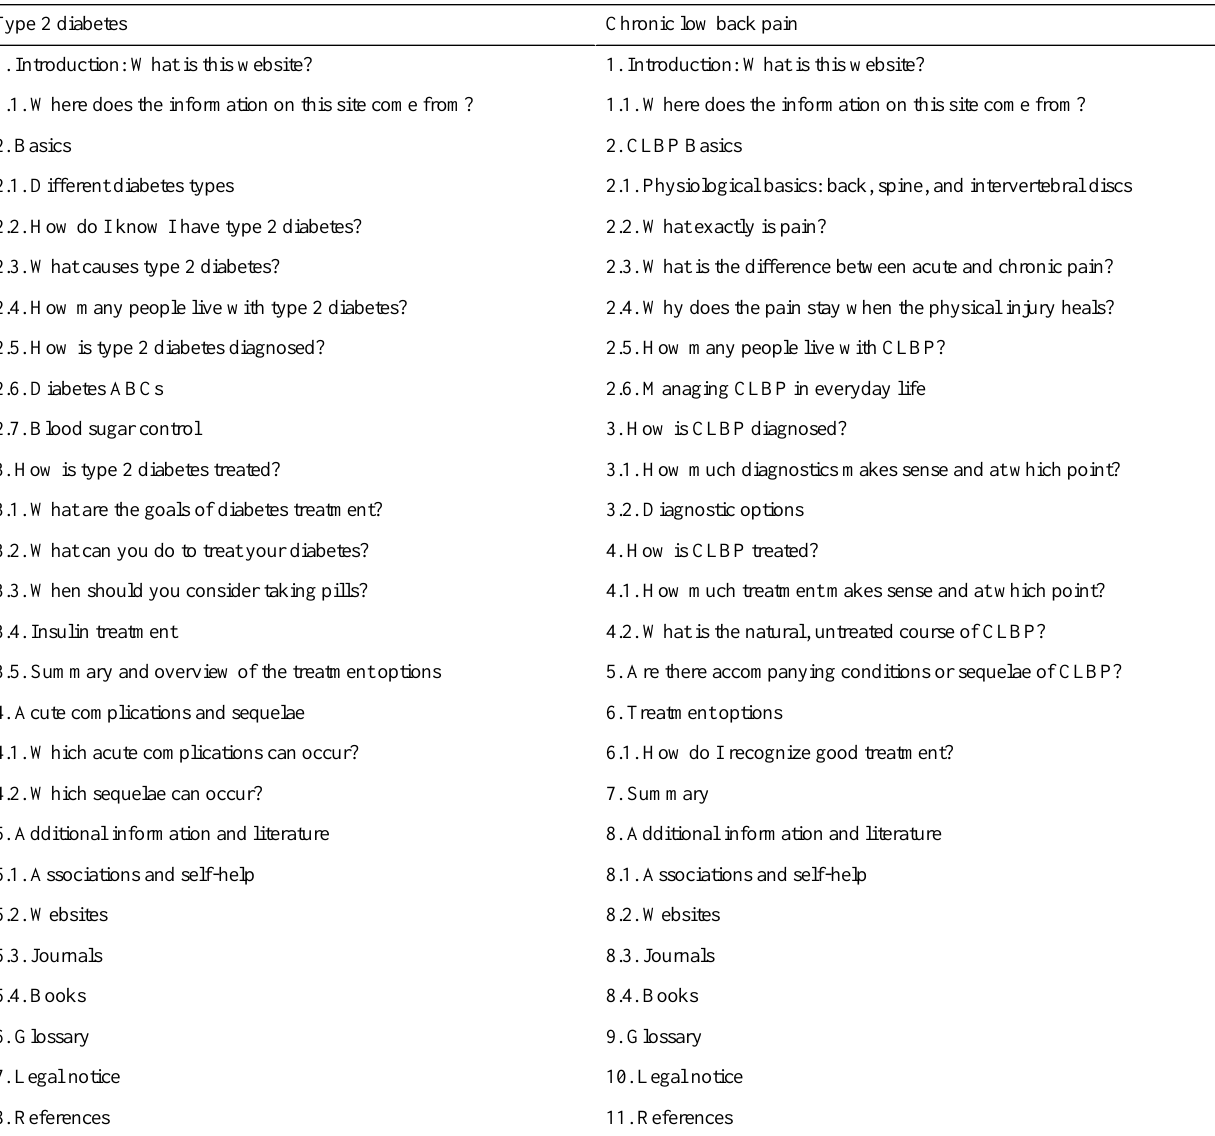
Table 1. Overview over the IHCA